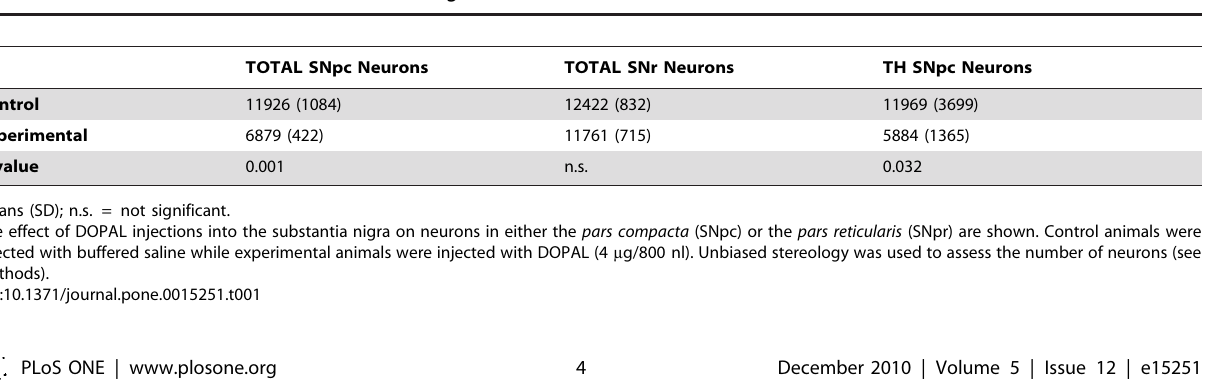
Table 1. Toxic Effect of DOPAL on Substantia Nigra Neurons.